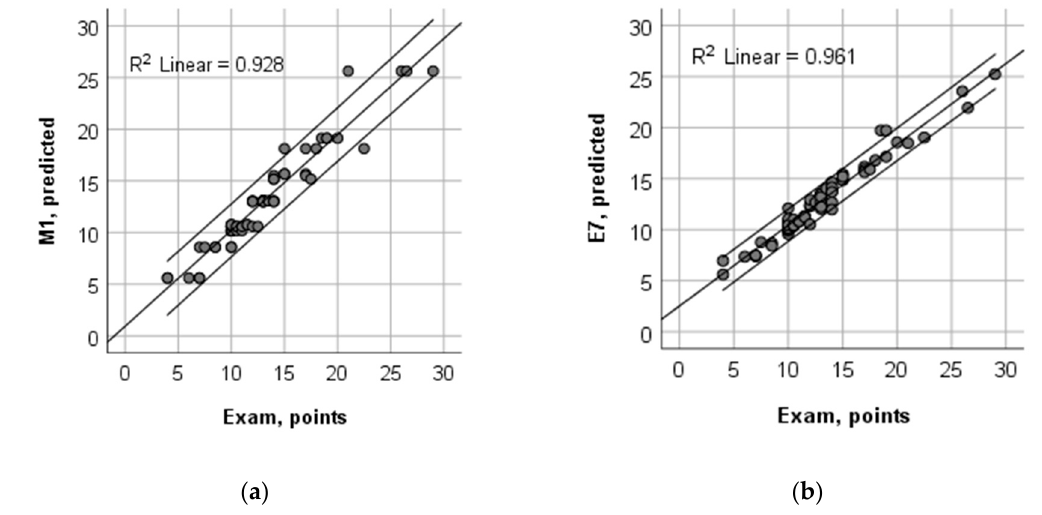
Figure 6. Scatter plots of predicted versus actual values of the target variable Exam with 5% confidence interval for ( a ) CART model M 1 and ( b ) CART-EB model E 7 .